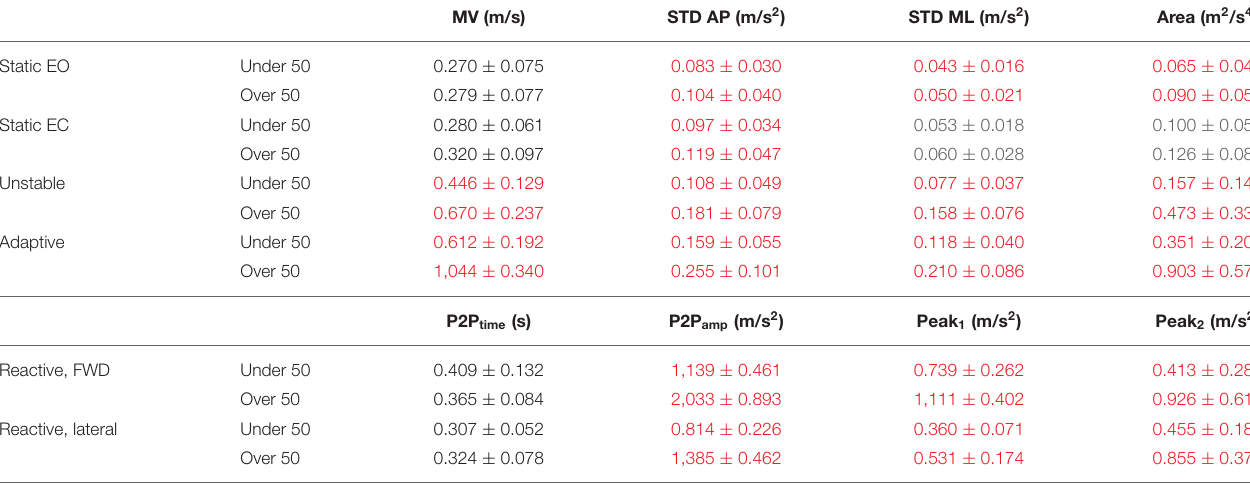
The colors are used to report statistical results of the comparison between subjects under 50 and subjects over 50: in red the values which resulted statistically significant (p < 0.001), in gray parameters with a non-statistically significant p, but with p ∼ 0.1. Specifically, for each exercise, for each parameter, we reported mean ± std both for subjects under and over 50. Each row is referred to the exercise reported in the corresponding row of the first column, namely static EO, static EC, unstable, adaptive, reactive FWD, and reactive lateral. In the upper part of the table, each column is referred to the parameter indicated in the first row: MV (mean velocity), STD AP (Antero-Posterior variability), STD ML (Medio-Lateral variability), and SA (sway area). In the lower part of the table, each column is referred to the following parameters: P2P amp (peak-to-peak amplitude), P2P time (time distance between Peak 1 and Peak